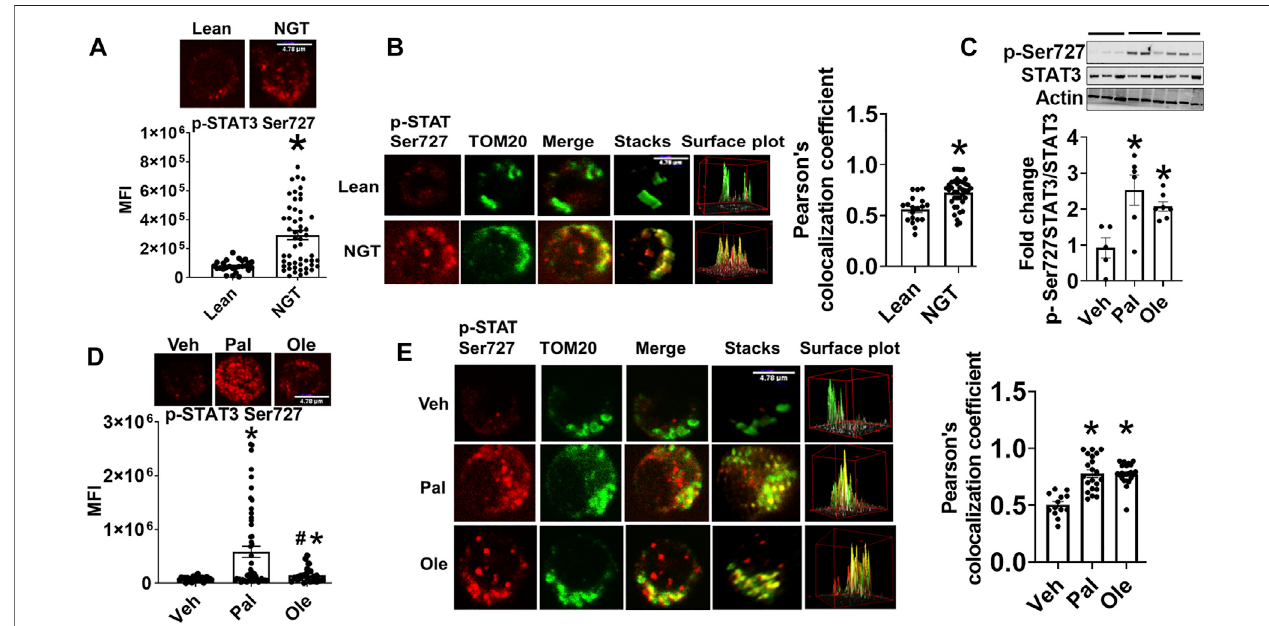
FIGURE 1 | Obesity and excessive fatty acids induce mitochondrial accumulation of p-Ser 727- STAT3. (A) p-Ser727 STAT3 quanti fi cation in CD4 + T cells from lean or obese/normal glucose-tolerant (NGT) subjects. (B) Localization of p-Ser727 STAT3 (red) and the Mitochondrial OM protein TOM 20 (green) in CD4 + T cells from lean or NGT subjects. Left panel shows representative images and right panel shows quanti fi cation of multiple cells. (C) p-Ser727 STAT3 expression in PBMCs after treatment with fatty acids assessed by immunoblotting (D) p-Ser727 STAT3 expression and (E) mitochondrial localization of p-Ser727 STAT3 (red) and the mitochondrial OM protein TOM 20 (green) in CD4 + T cells from lean subjects after fatty acid treatment. Left panel shows representative images and right panel shows quanti fi cation of multiple cells. N = 7 – 8, (A,B,D,E) and N = 5, (C) Each N represents cells obtained from one subject. At least 7 – 10 fi elds per slide were imaged at 63× magni fi cation with oil immersion, on a Zeiss LSM 800 confocal microscope. In fi elds where numerous cells/ fi elds were observed, the averages are plotted. The brightness of the images was enhanced to improve clarity. The “ control ” representative images for lean and NGT (Panel 1B) are repeated in panels ( Figure 2B , Figure3B ,and Figure7E ).Similarly,therepresentativeimagesforVeh,Pal,andOle(1E)arerepeatedinpanels( Figure4B , Figure4E ,and Figure7F )* p < 0.05vslean or veh, # p < 0.05 vs palmitate treatment.